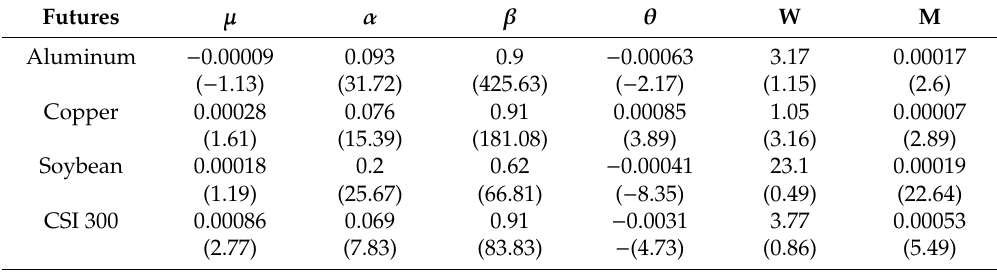
Table 7. Parameter estimates of one side GARCH-MIDAS model with industrial production